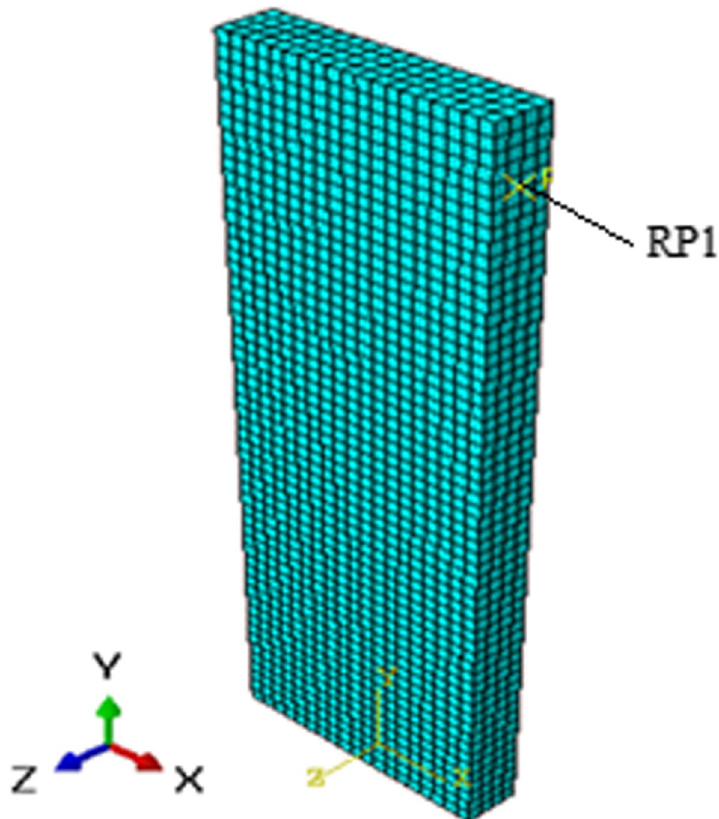
Fig. 7 Meshing used in the